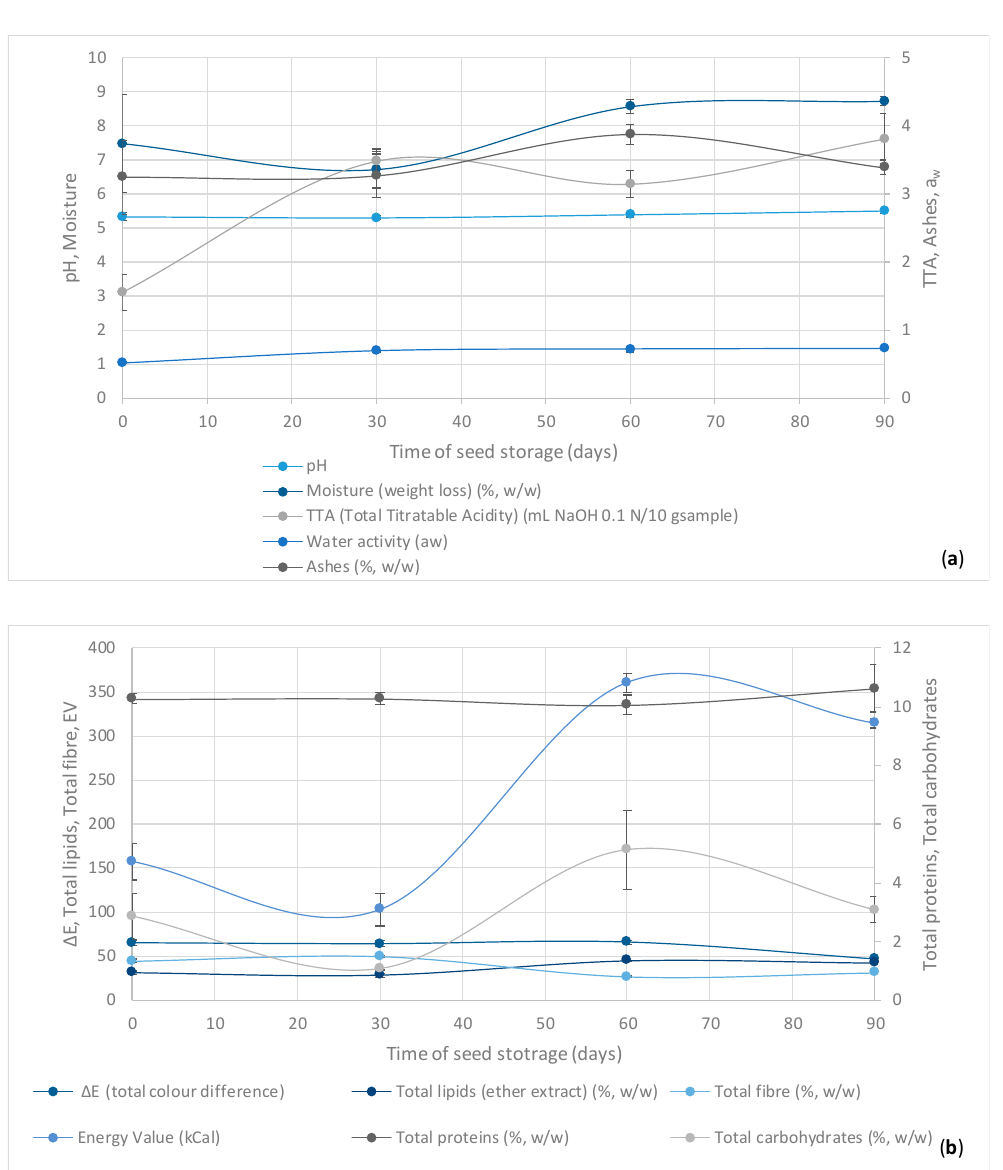
Figure 7. Average values and standard deviations (mean ± STDV) from 3 analytical repetitions for different physicochemical parameters throughout 90 days of storage of cupuaçu beans : ( a ) pH, Moisture (weight loss) (%, w/w ), Total Titratable Acidity (TTA) (mL NaOH 0.1 N/10 g sample ) and Water activity (a w ); and ( b ) Total color difference ( Δ E), Total lipids (ether extract) (%, w/w ), Total fiber (%, w/w ), Total proteins (%, w/w ), Energy value (%, w/w ), Total proteins (%, w/w ), and Total carbohydrates (%, w/w ).